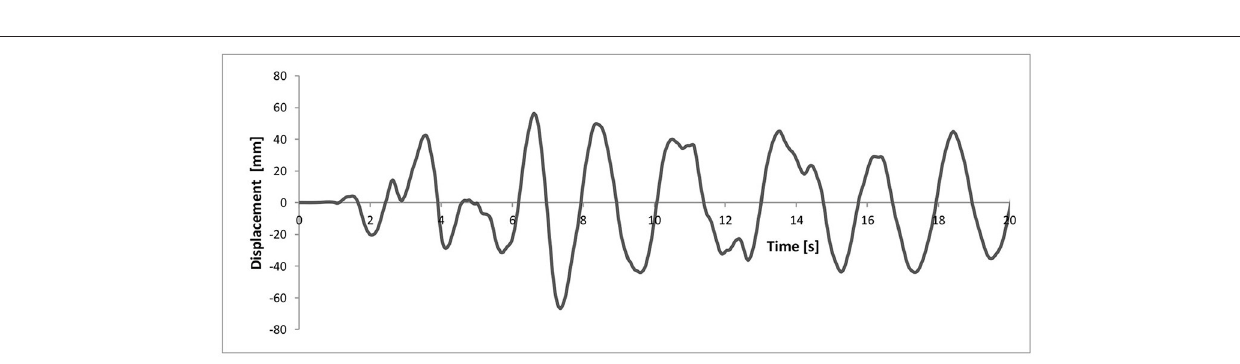
FIGURE 9 | Time history of the relative displacement of device #1, used for computing the device response to variable axial force depicted in Figure 10 .